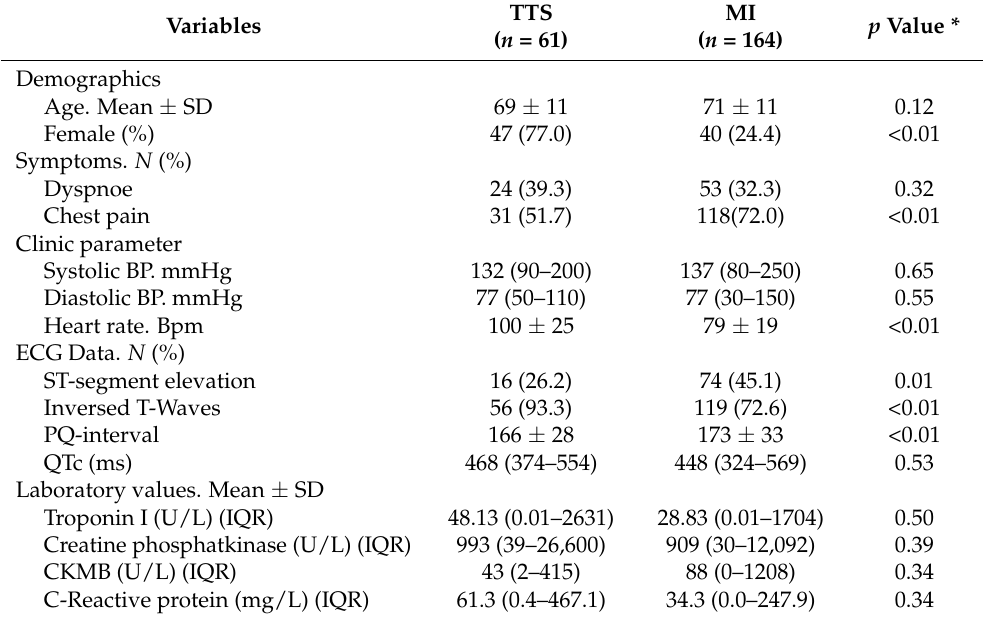
Table 1. Baseline characteristics of 61 patients initially presenting with takotsubo cardiomyopathy (TTS) and kidney failure (KF) and 164 patients presenting with myocardial infarction and KF.